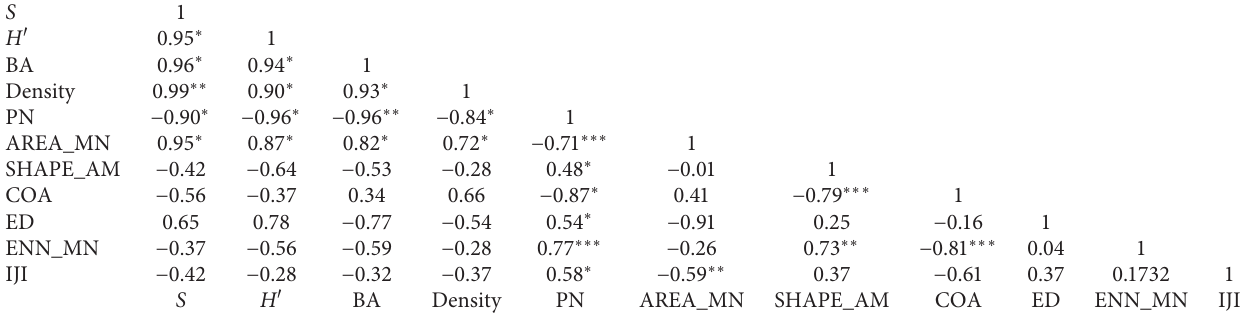
Table 7: Pearson’s correlation coefficient between the landscape indices and floristic composition and structural